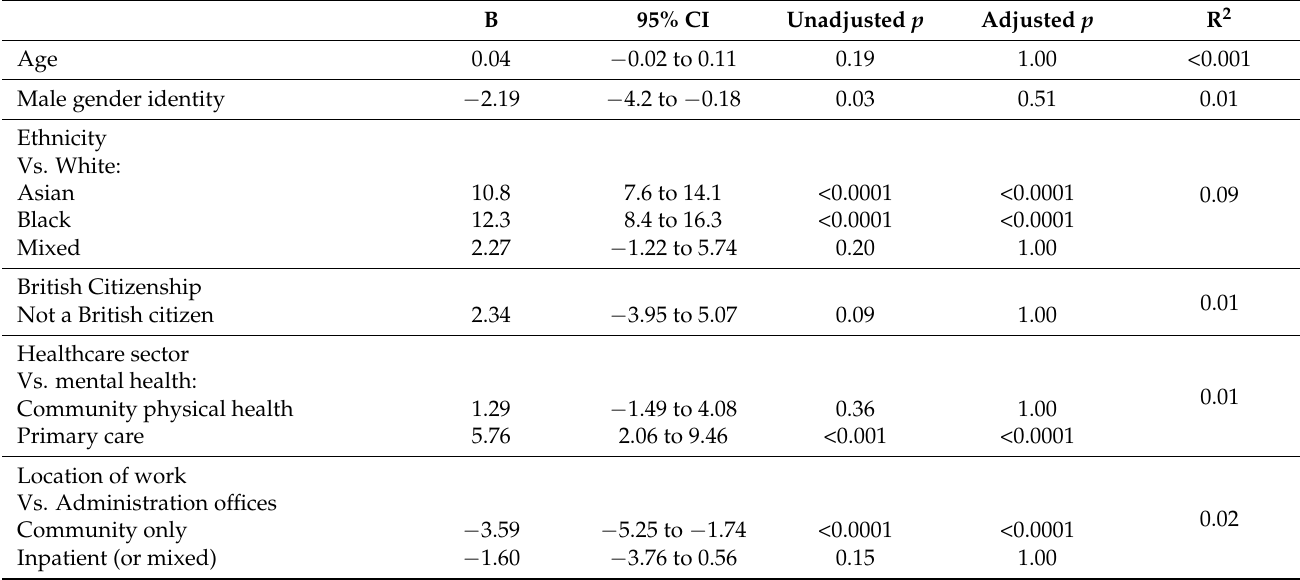
Table 1. Individual predictors of post-traumatic growth (total score on the brief Post-Traumatic Growth